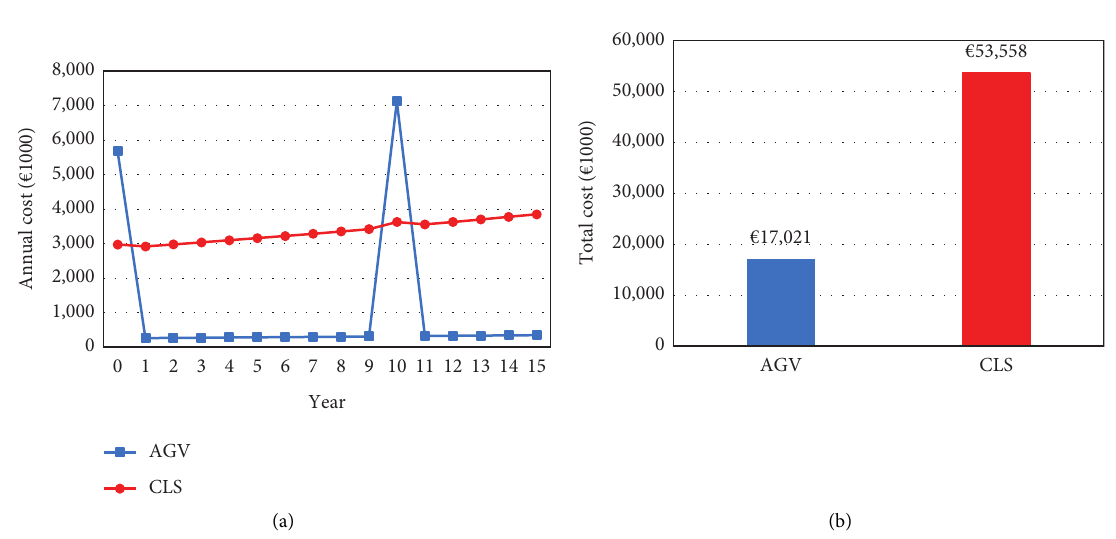
Figure 6: Total operating costs for the current and AGV loading systems: (a) each year and (b) for a 15-year period (source: